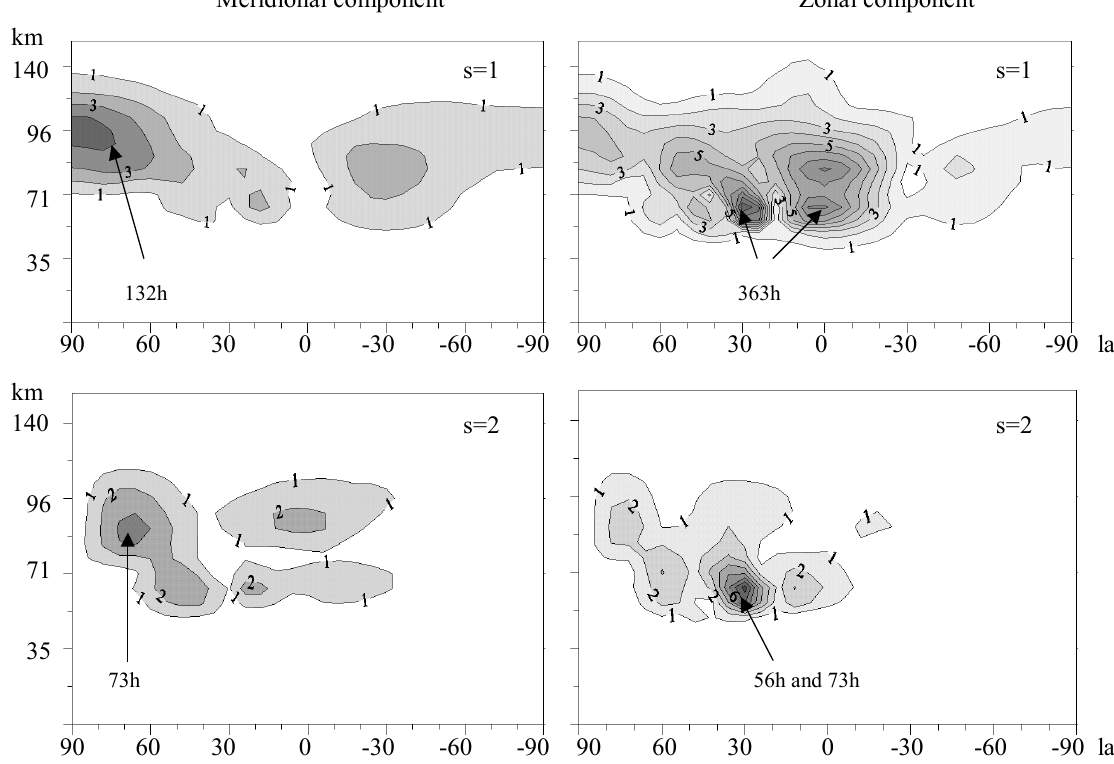
Fig. 7. Amplitude distributions (m/s) of secondary waves for zonal wave numbers 1 and 2. Arrows relate areas of largest amplitudes to periods of corresponding oscillations. Axis labels are approximate altitude and